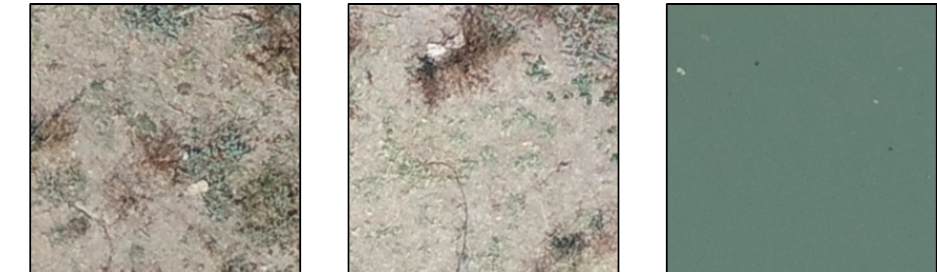
Figure 12. Both the HMH model and the TT model with transfer learning fail in some cases. Neither model detected any plastic in these images.